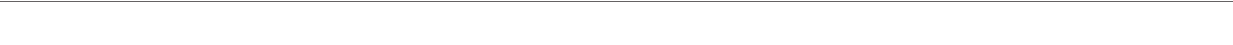
FIGURE 2 | In the Proprioceptive pointing task the participants were asked, with their eyes closed, to mark on a ruler (proximally to distally from their own body) with their index finger on the sound hand, where they estimated the location of: (1) the prosthetic index finger and (2) where they experienced their phantom index finger. TABLE 1 | Example from the condensation in the directed content analysis. Meaning unit Code Category Feel the grasp Sensory feedback from the prosthesis